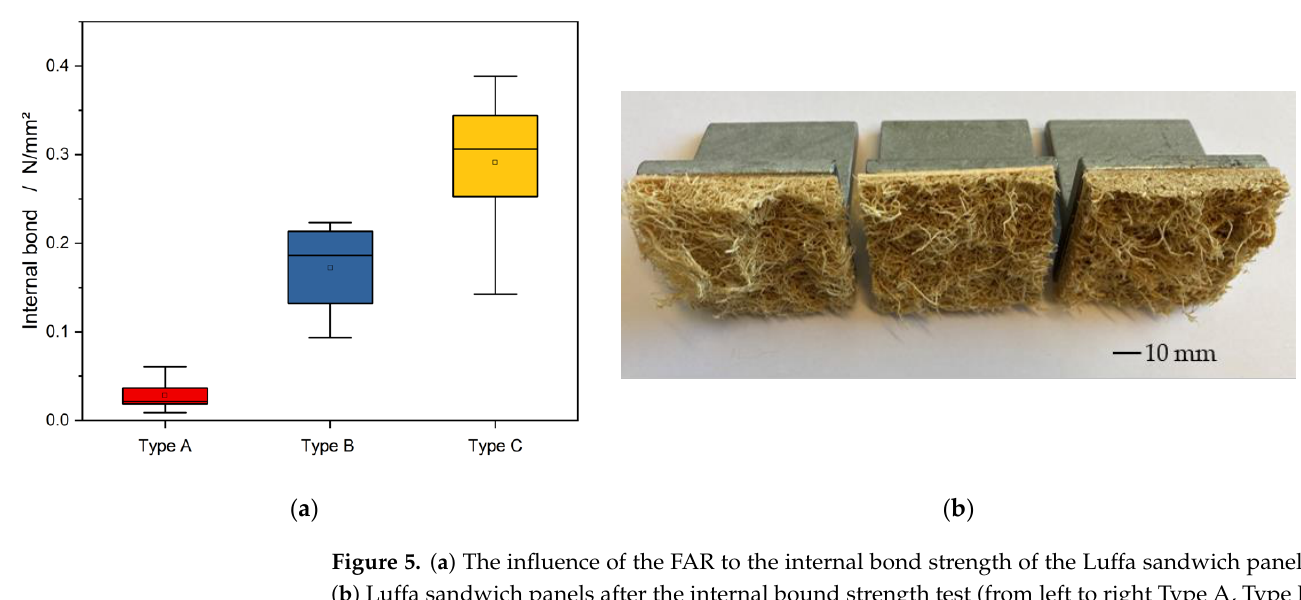
Figure 5. ( a ) The influence of the FAR to the internal bond strength of the Luffa sandwich panels. ( b ) Luffa sandwich panels after the internal bound strength test (from left to right Type A, Type B, and Type C).